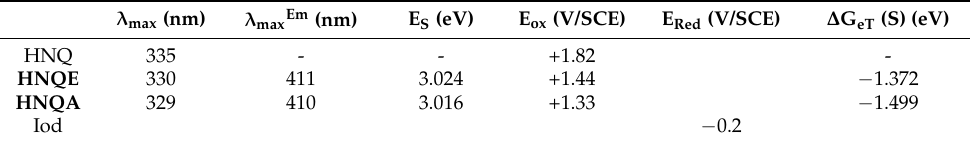
Table 2. Photophysical properties of HNQ, HNQE, and HNQA in